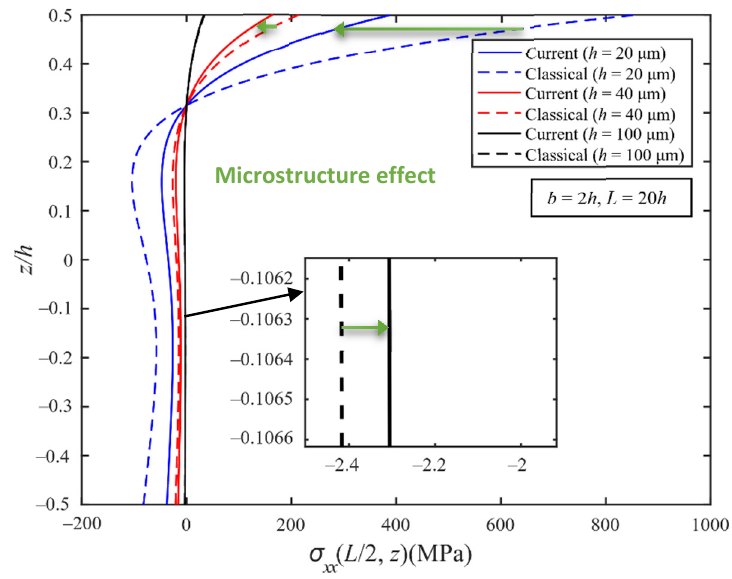
Figure 6. Axial normal stress of the MEE-FGM simply supported beam (Gradient index n = 5).